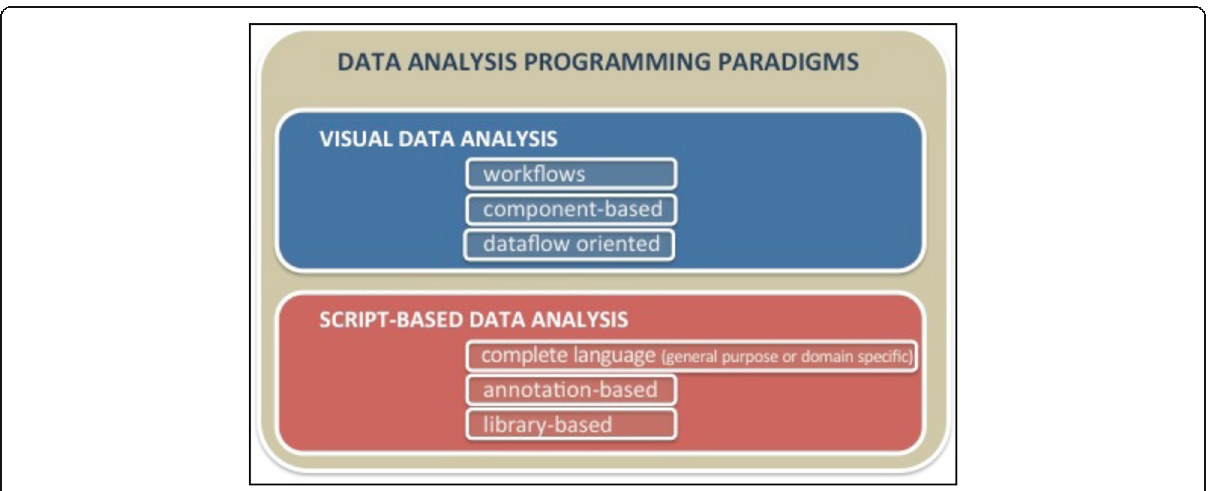
Fig. 3 Main visual and script-based programming models used today for data analysis